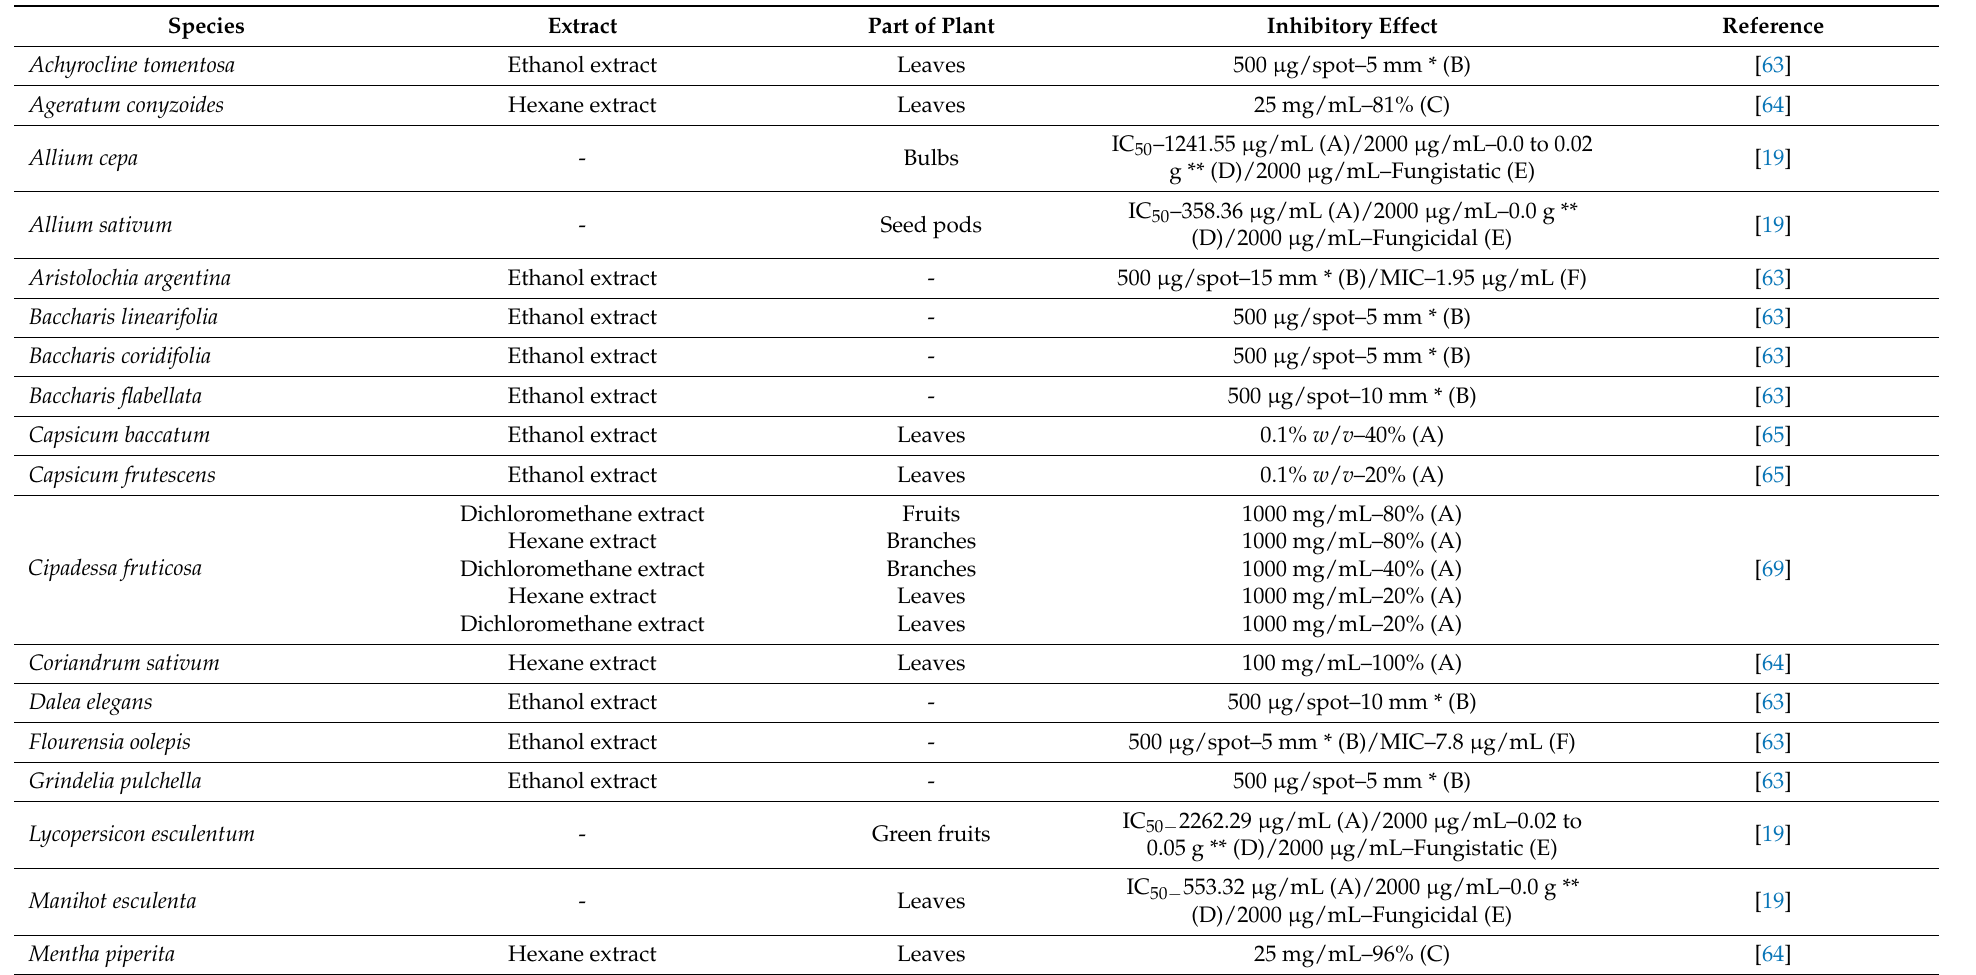
Table 1. Plant extracts and essential oils with potential antifungal effects against Leucoagaricus gongylophorus by in vitro